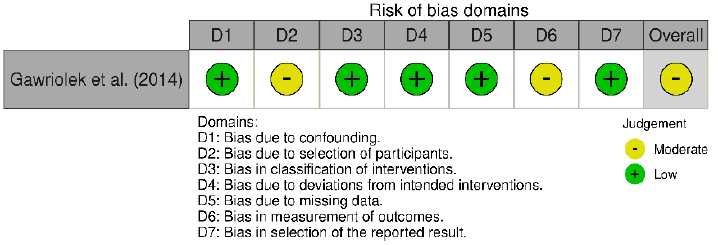
Figure 2. Cochrane risk-of-bias tool for randomized trials (RoB 2) [17,19,21,22].